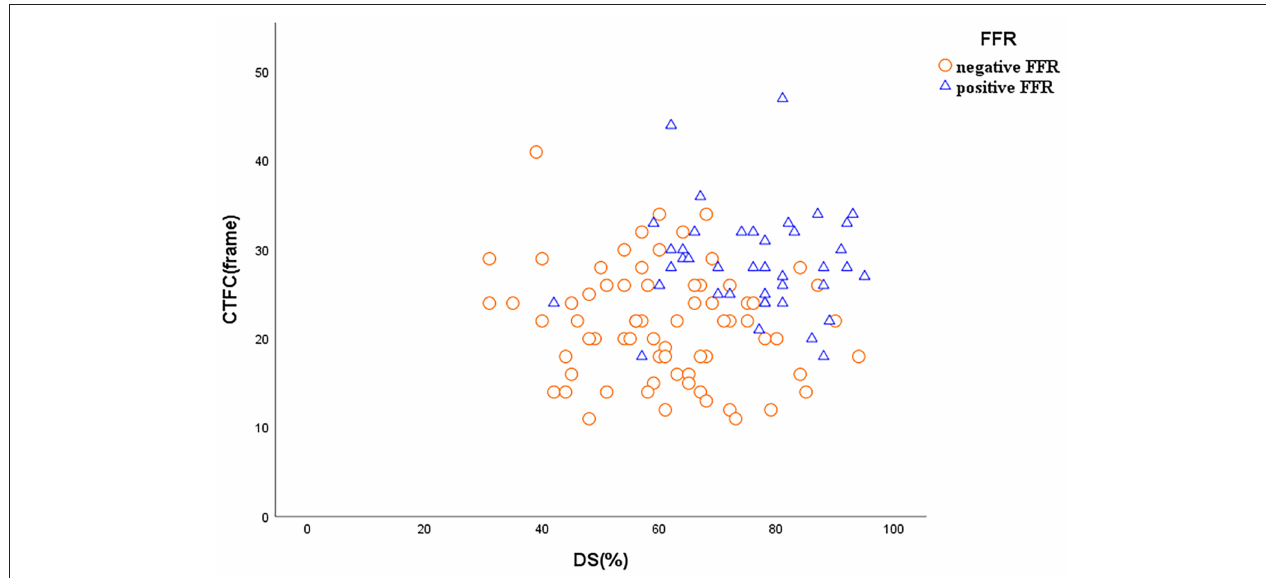
FIGURE 3 | Scatterplots of DS and